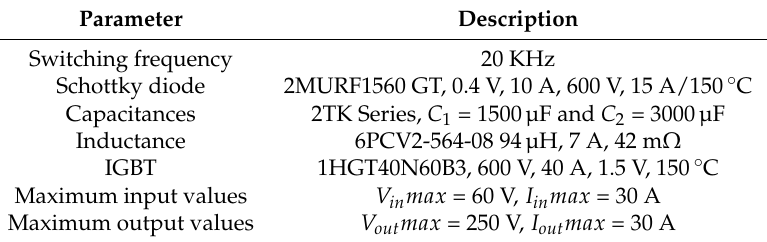
Table 4. Technical data of the DC/DC